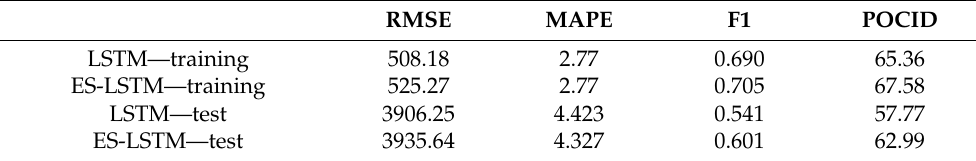
Figure 5. BTC–USD data set versus its filtered version.